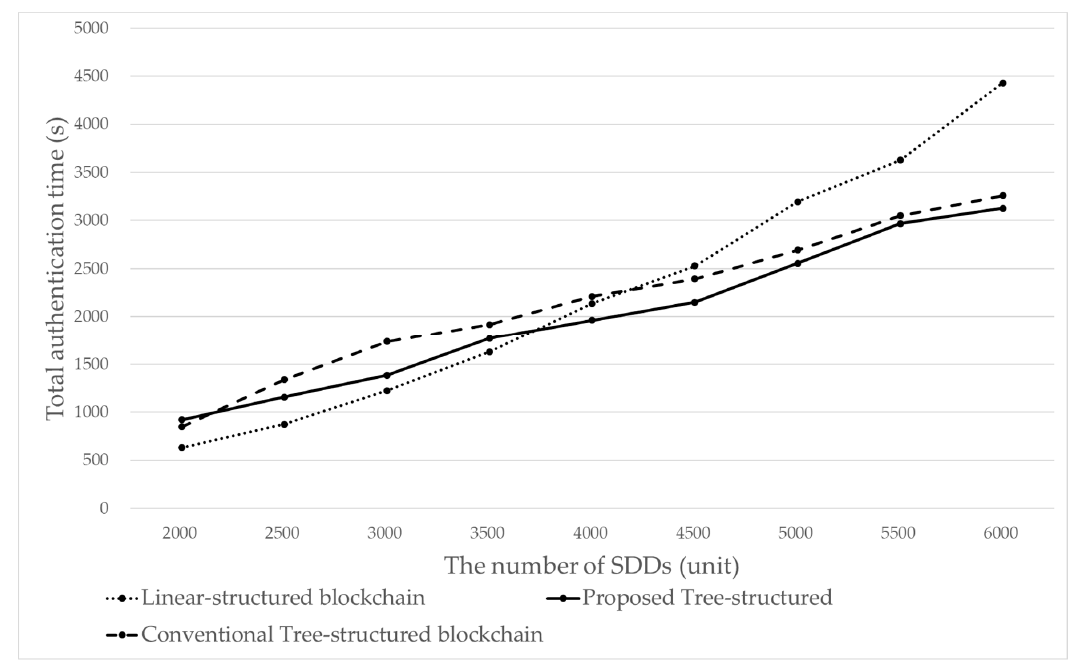
Figure 11. The total authentication time of all SDDs .